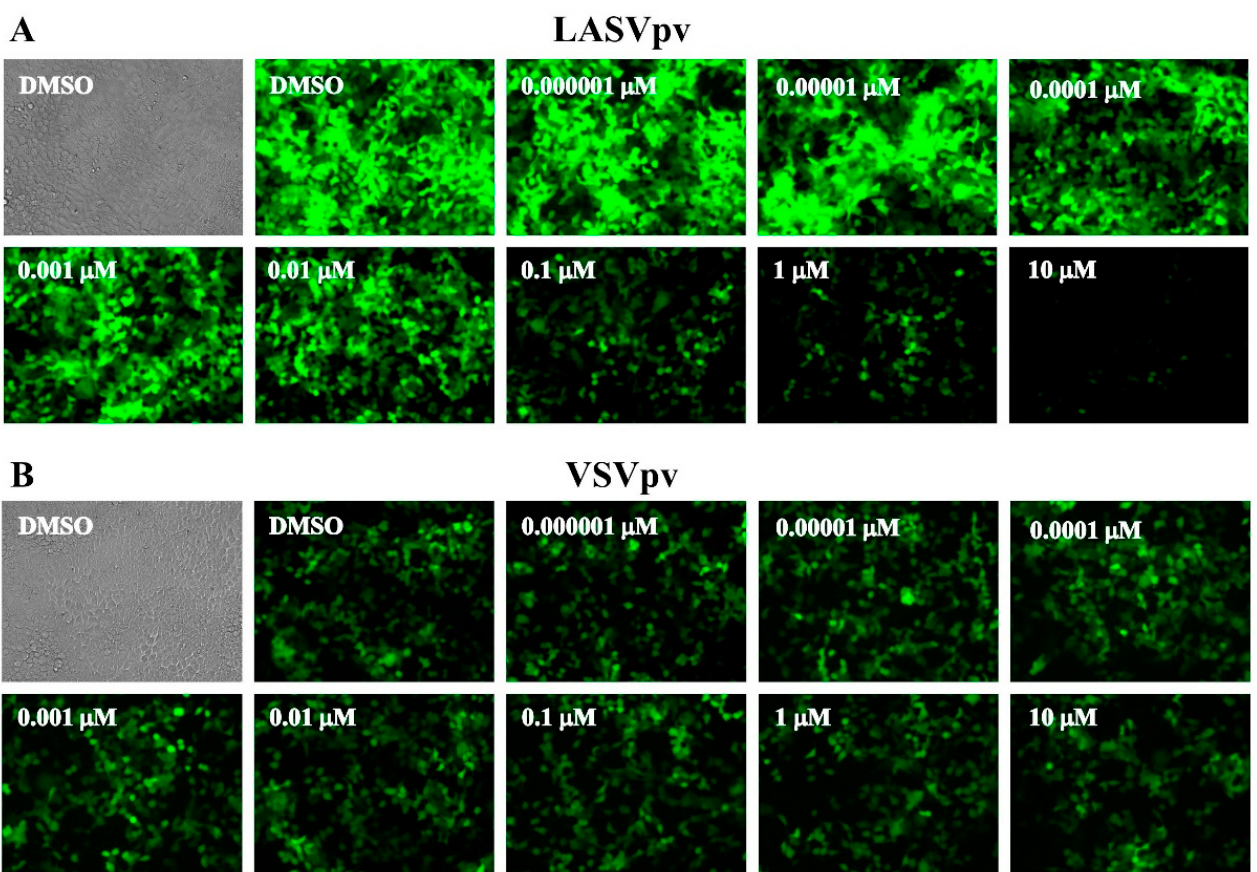
Figure 2. Expression of EGFP in pseudovirus-infected HEK-293 cells. ( A ) The positive drug LHF − 535 inhibited LASVpv infection in a concentration-dependent manner. ( B ) The positive drug LHF − 535 shows little or no effect on pseudotyped viruses expressing the VSVpv.